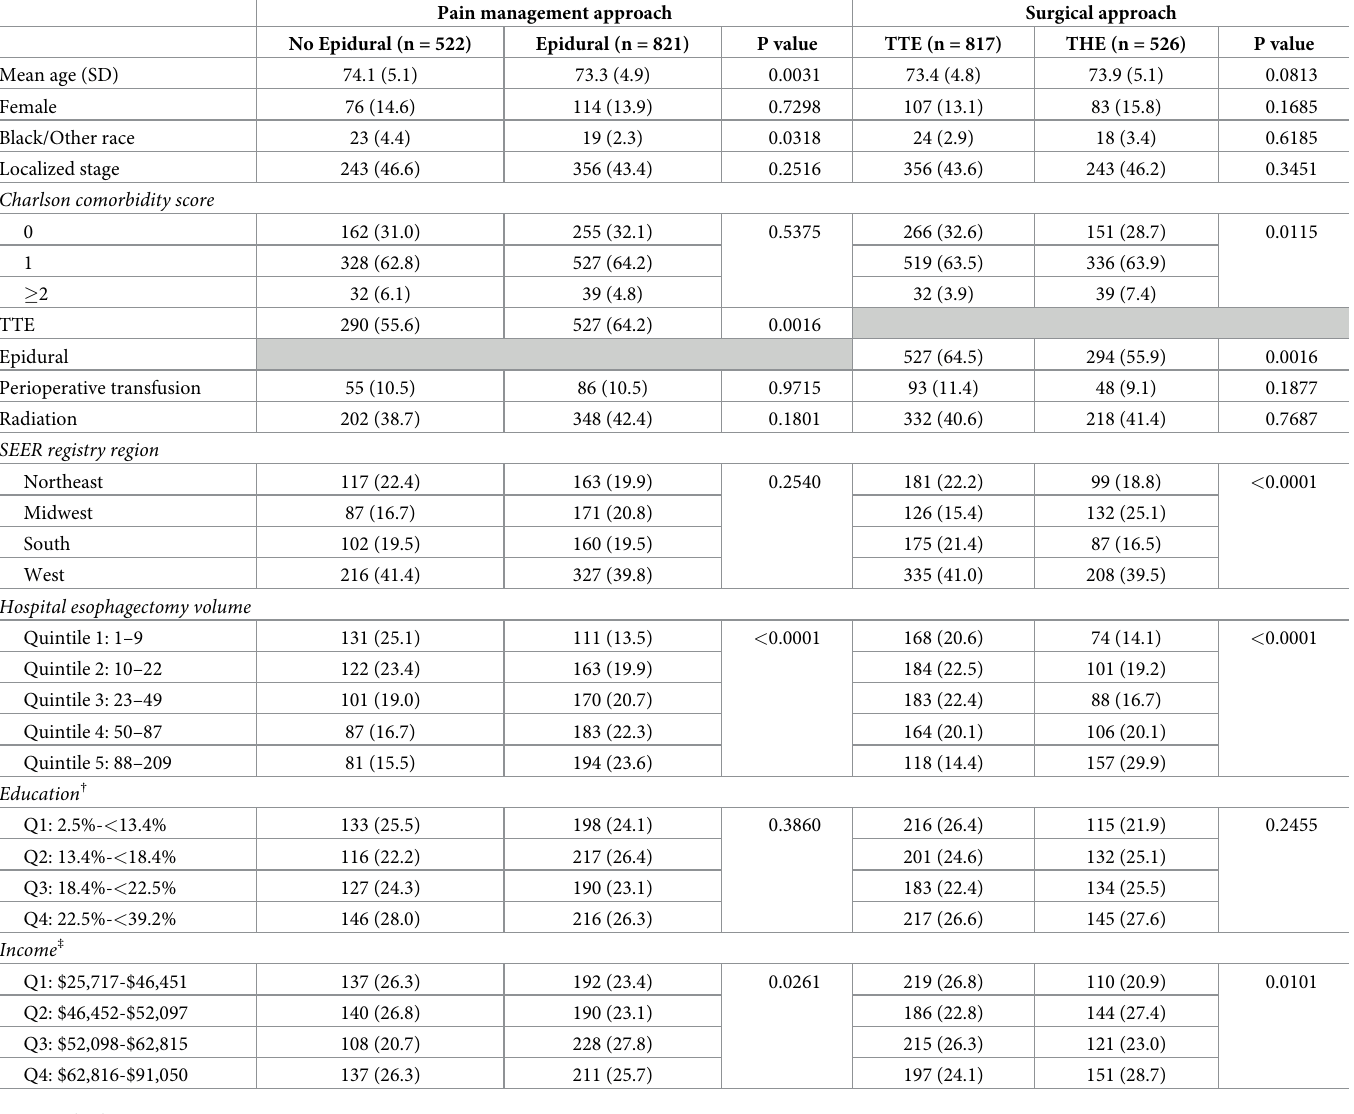
Table 4. Baseline characteristics among adenocarcinoma patients by pain management approach and surgical approach. Pain management approach Surgical